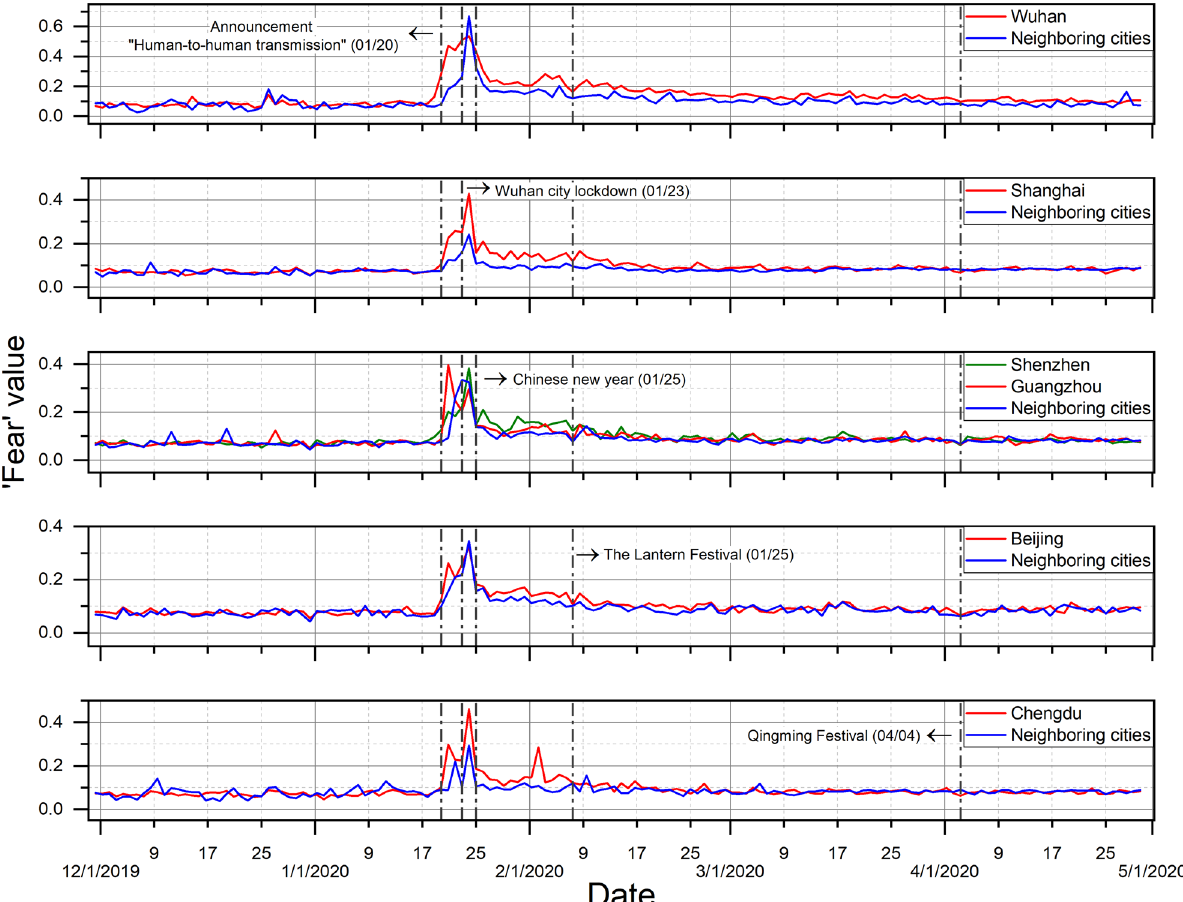
Fig. 2 The distribution of the emotion “ fear ” over time in different cities. This line chart compares the changes in the emotion “ fear “ of different central cities and their neighboring